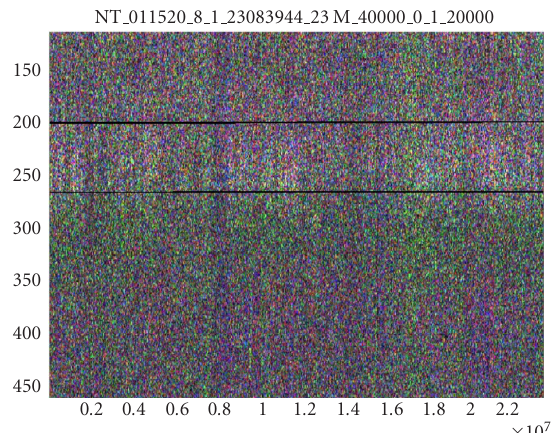
Figure 11: NT 011520.8 (23Mbp in length) of human chromo- some 22. The two artificial black lines mark the 150-base and 200- base periodicities. This band of intensity may relate to the folding of DNA into nucleosomes.